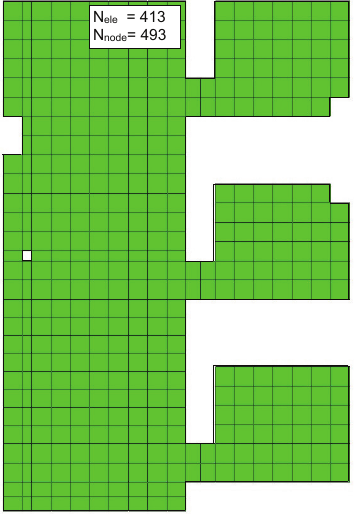
Figure 9. PUFEM mesh for coupled room analysis: The n w range is the same as Mesh 2 in Figure 3.